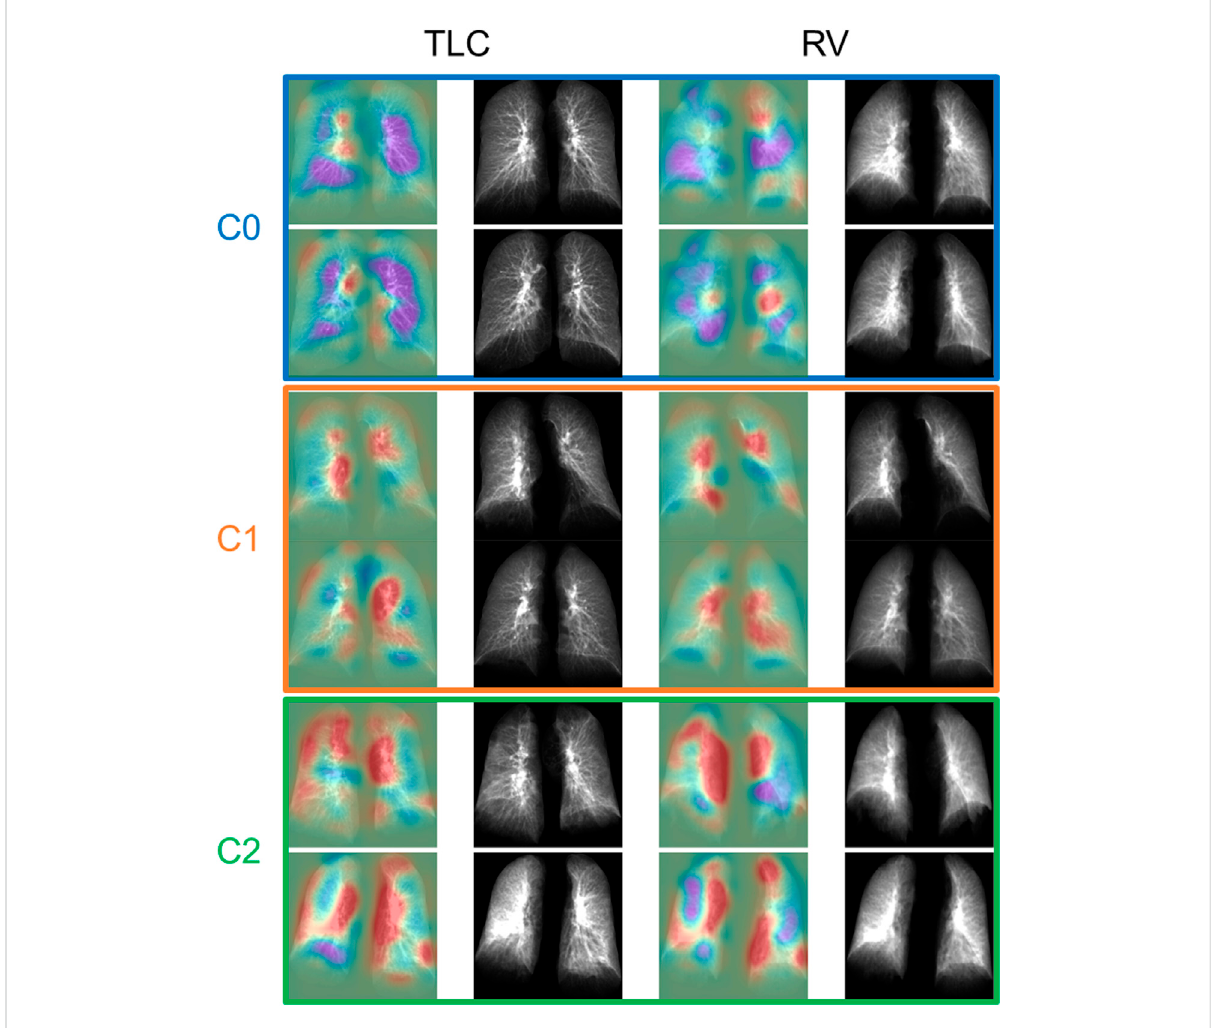
FIGURE 4 The TLC and RV images of the representative subjects for each cluster. The fi rst and the third column showed the activation maps which indicated the important regions for determining if the subjects were post-COVID-19 subjects (red) or control subjects (purple).